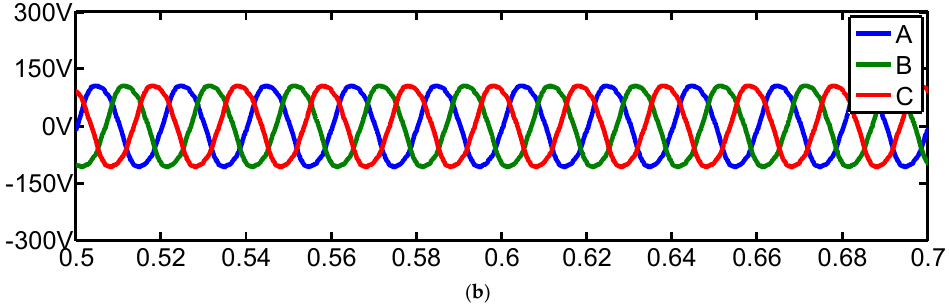
Figure 25. Output voltages for different MMC topologies with trapezoidal modulation under λ = 0.5. ( a ) Output voltage under traditional MMC. ( b ) Output voltage under the proposed hybrid MMC.